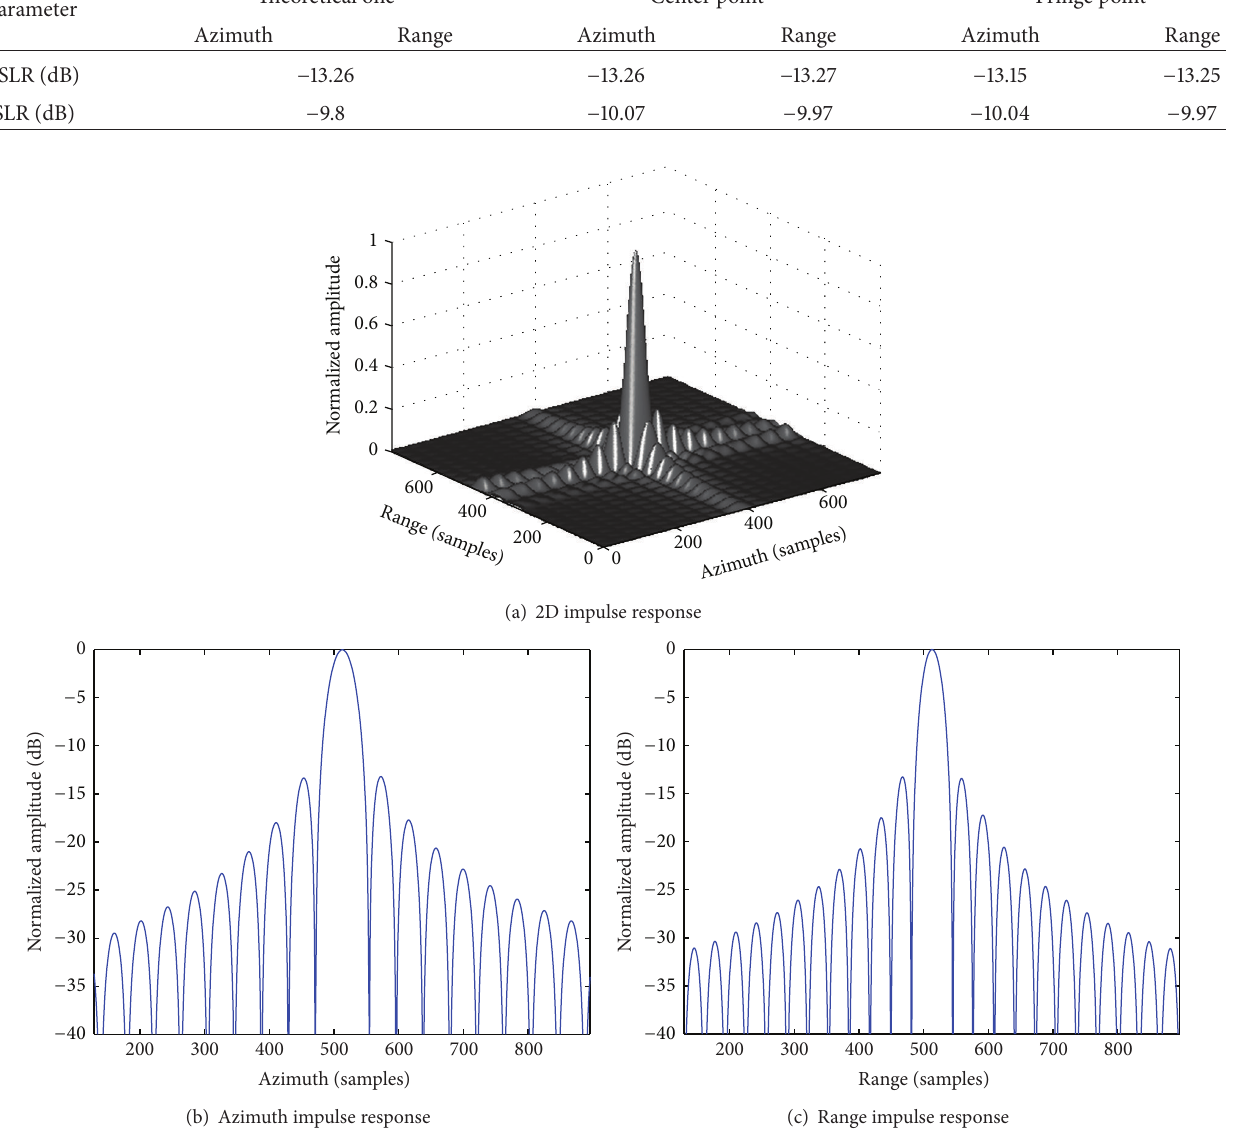
Figure 3: Center point results using the proposed range